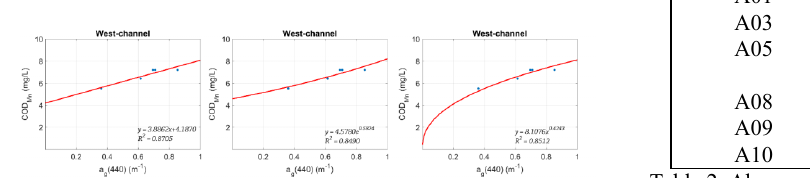
Figure 3. Measured values of water colour constituents versus COD Mn in different parts of GPR